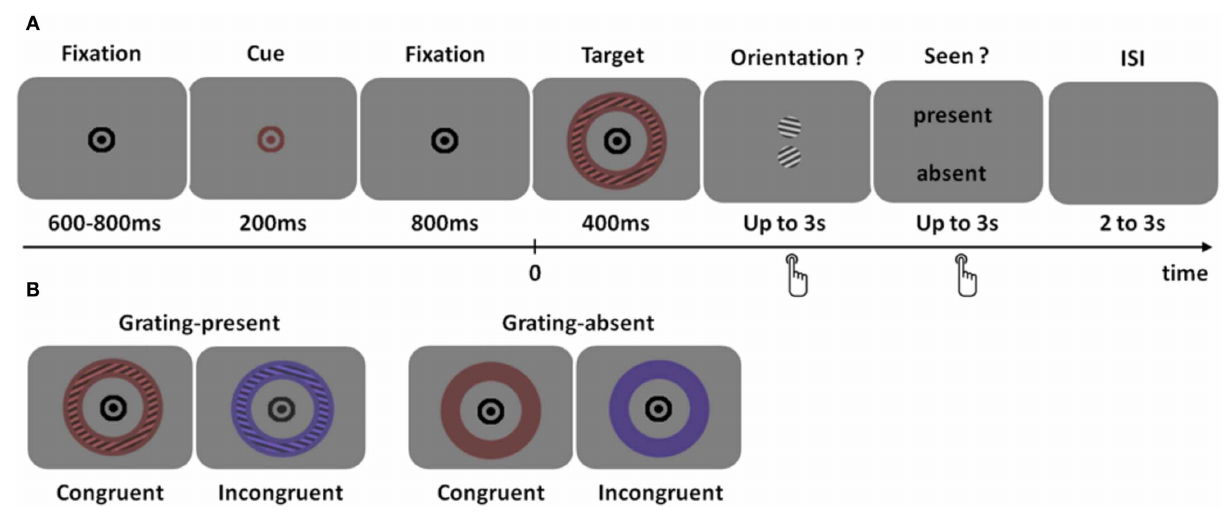
FIGURE 1 | Experimental design. (A) Trial time course. After a fixation interval of 600–800 ms, the fixation point briefly changed color, indicating the most likely color of the upcoming stimulus. The target was a colored annulus that contained, in most trials, a faint grating at threshold for consciousness. The color of the stimulus could be identical to that of the cue (congruent trials) or not (incongruent trial). Subjects had